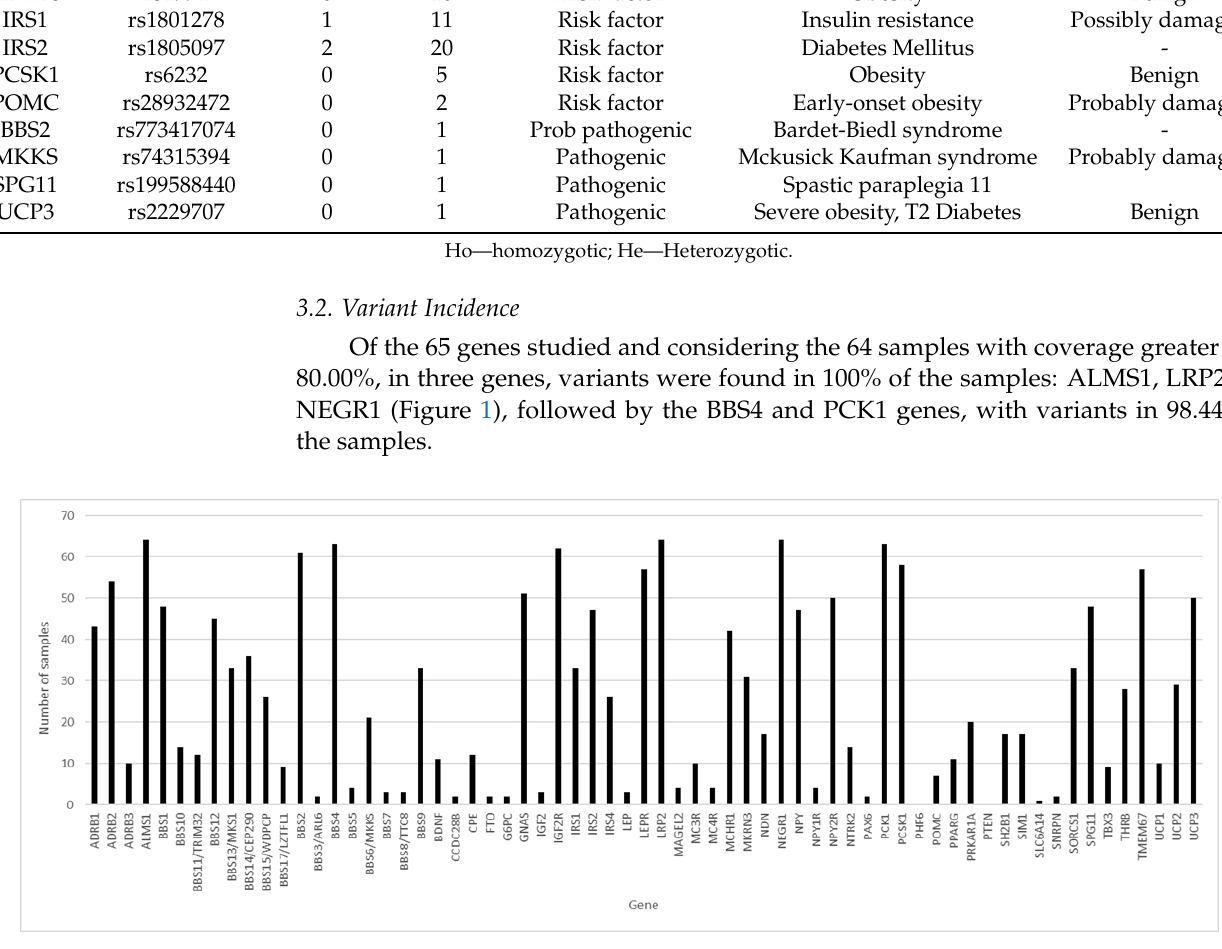
Figure 1. Number of samples where variants were detected, by gene. The Y axis represents the number of samples, and the X axis the name of genes.